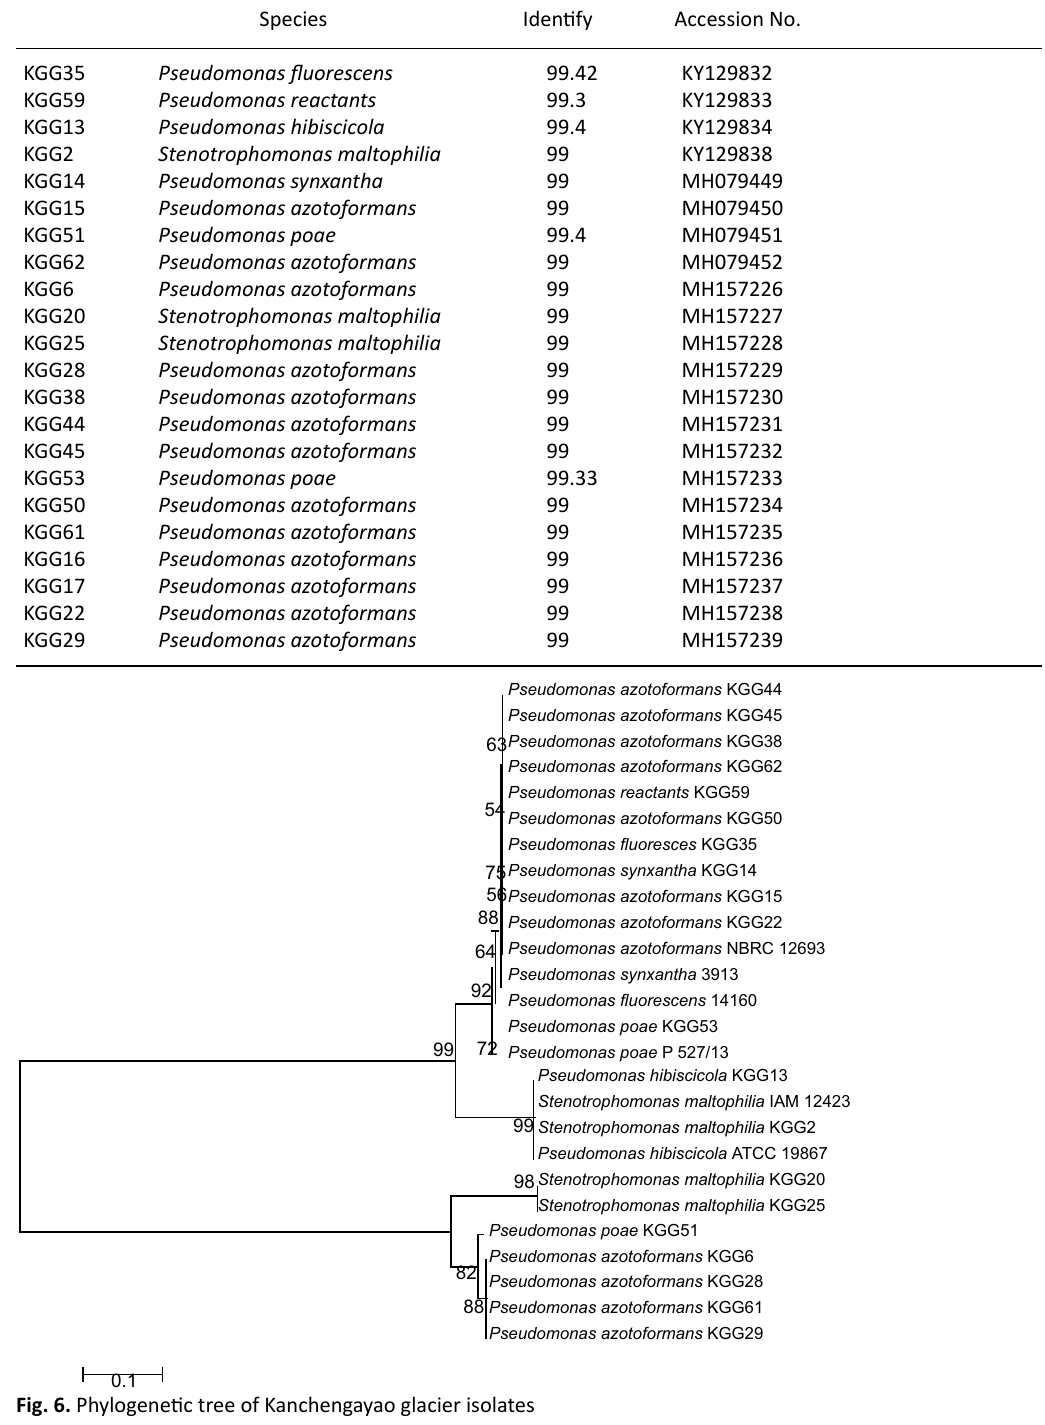
Fig. 6. Phylogenetic tree of Kanchengayao glacier isolates